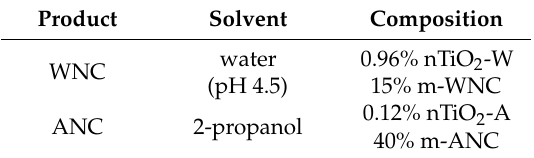
Table 2. Composition ( w / w ) of WNC and ANC, as reported by the Table 2 . Composition ( w / w ) of WNC and ANC, as reported by the producers.